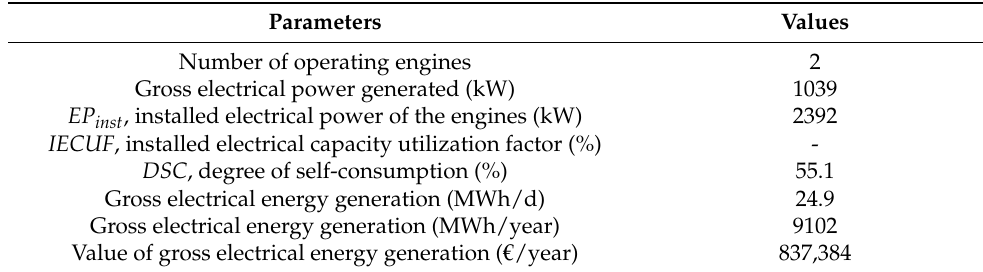
Table 8. Results from the energy balance of the